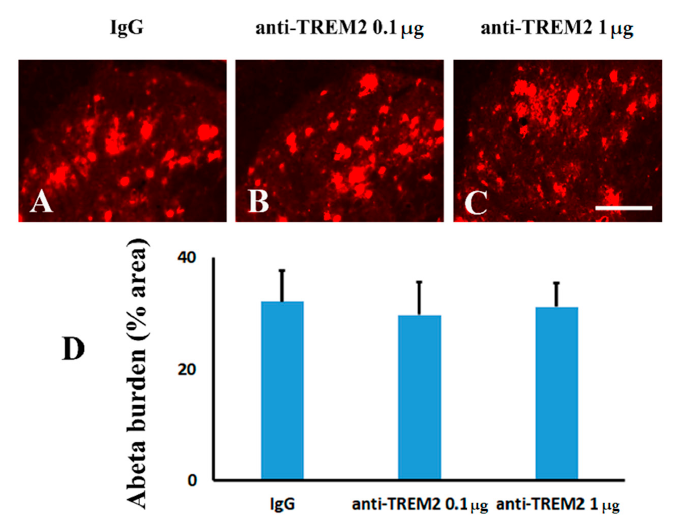
Figure 8. Functional blockage of spinal TREM2 did not attenuate A β plaques in the dorsal horn of TgCRND8 mice following peripheral nerve injury. ( A ): IgG. ( B ): anti-TREM2 at a dose of 0.1 µ g. ( C ): anti-TREM2 at a dose of 1 µ g. ( D ): Quantification of A β plaques in the ipsilateral dorsal horn following TREM2 antibody treatment in the mice following peripheral nerve injury. Scale bar, 150 µ m.